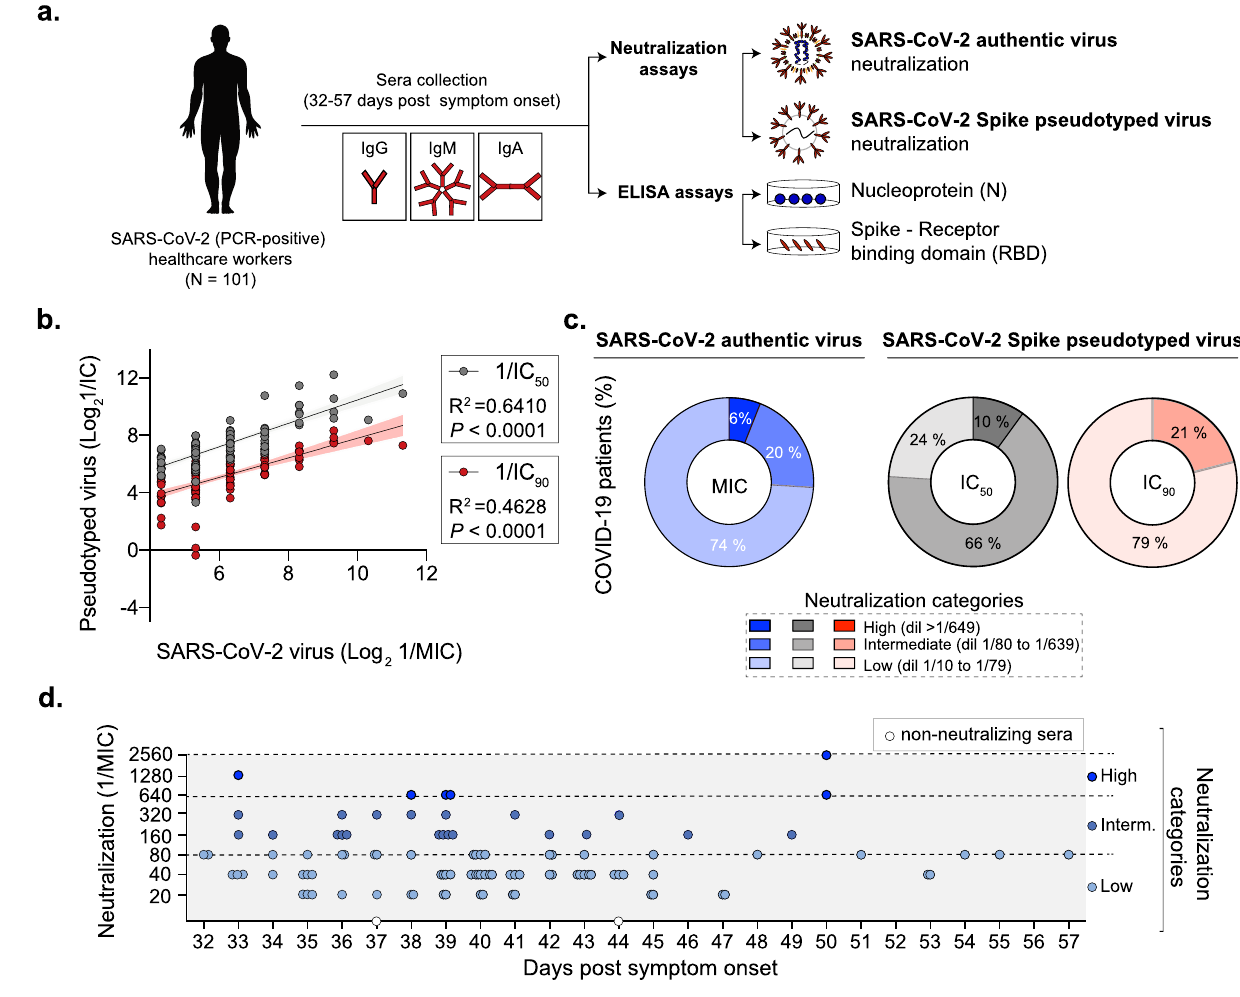
Figure 1. SARS-CoV-2 neutralizing antibody response. ( a ) Schematic representation of the experimental design. ( b ) Correlation analysis of the sera neutralization level of 101 COVID-19 convalescent patients. The data presented are the log2 of the neutralization titer against the authentic SARS-CoV-2 virus (1/MIC) and the Spike pseudotyped virus 1/IC 50 or 1/IC 90 . Correlation and linear regression analyses were performed using GraphPad Prism 8. P values were calculated using a two-sided F test. ( c ) SARS-CoV-2 neutralization categories. Sera of convalescent patients was defined as low (dil 1/10 to 1/80), intermediate (dil 1/81 to 1/639) and high (dil > 1/640) based on authentic SARS-CoV-2 virus or Spike pseudotyped virus. ( d ) Distribution of authentic SARS-CoV-2 virus neutralization titers (1/MIC) over days post symptom onset. Dashed lines indicate the neutralization levels as defined in ( b ). White dots indicate two individuals with SARS-CoV-2 non-neutralizing